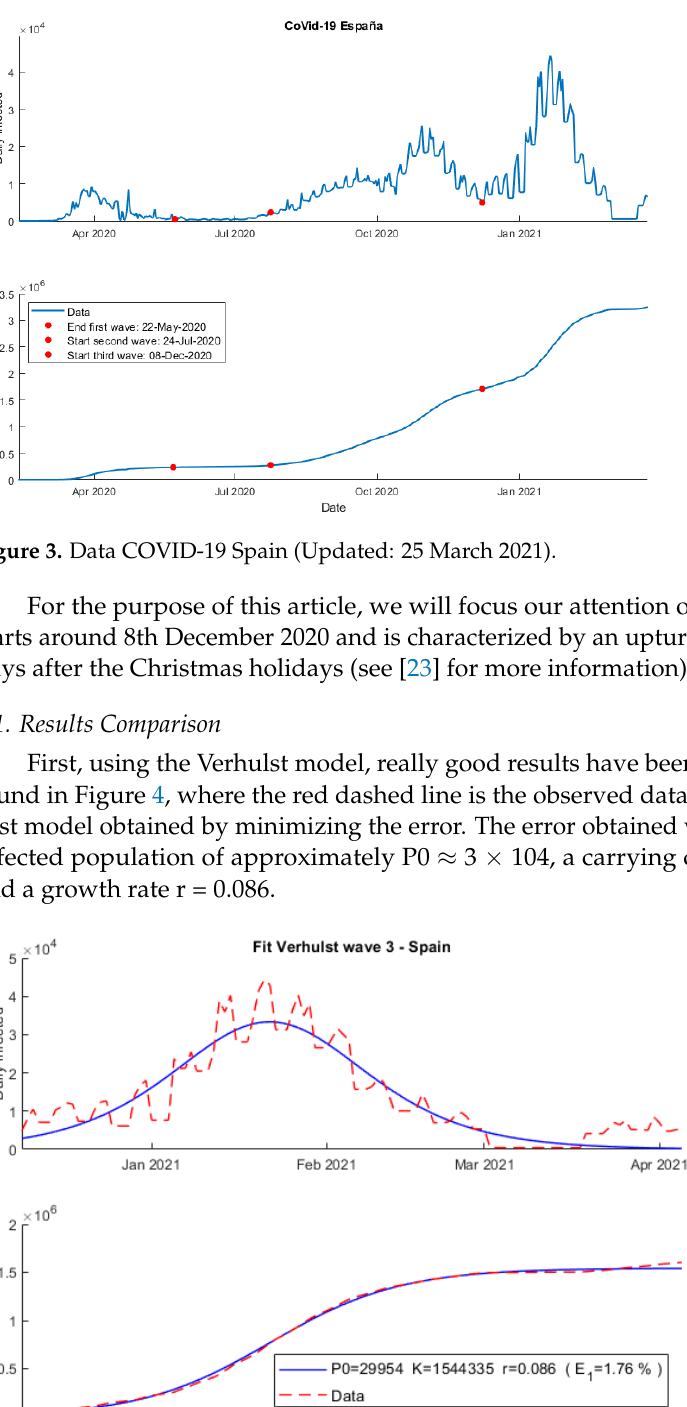
Figure 5. Fit using Gompertz’s model wave 3 COVID -19 Spain.